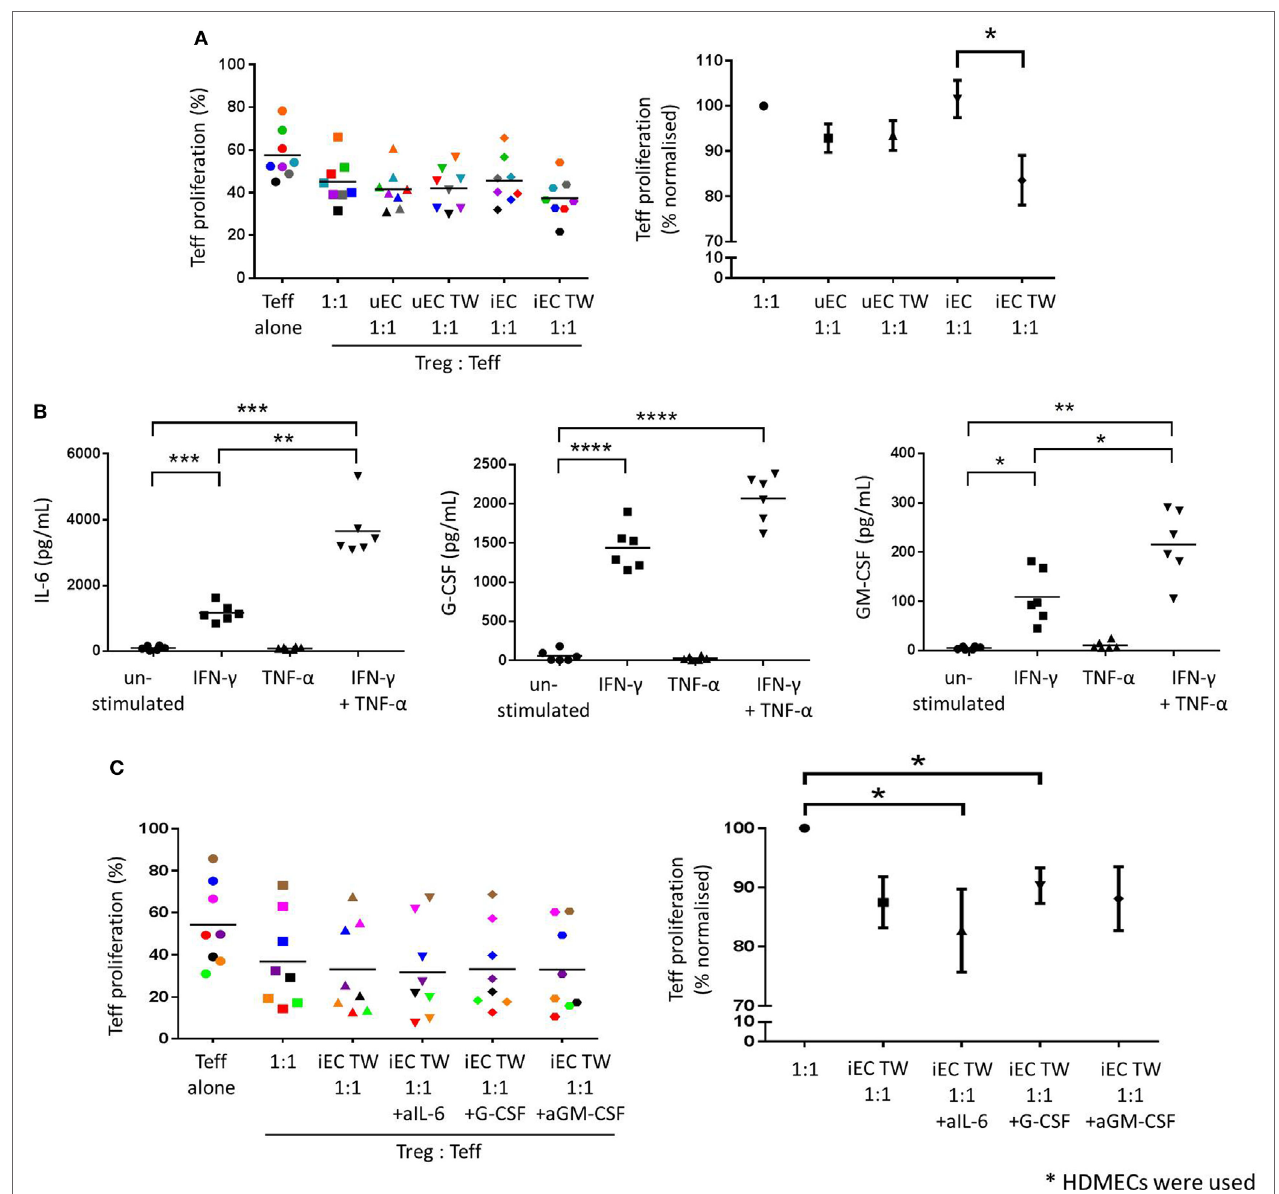
FigUre 4 | Increased Treg suppressive capacity through contact-independent interaction with activated HDMECs. (a) The effect of HDMEC interaction on Treg function was investigated whereby CD4 + CD25 hi CD127 low were plated in direct contact with unstimulated (uEC) or IFN- γ -stimulated (iEC) HDMECs, or suspended above unstimulated (uEC TW) or IFN- γ -stimulated (iEC TW) HDMECs in Transwells for 24 h, then recovered and plated in Treg suppression assays. Data are expressed as % proliferated Teffs, with each experiment represented by a different color. Data are also expressed where Teff proliferation is normalized